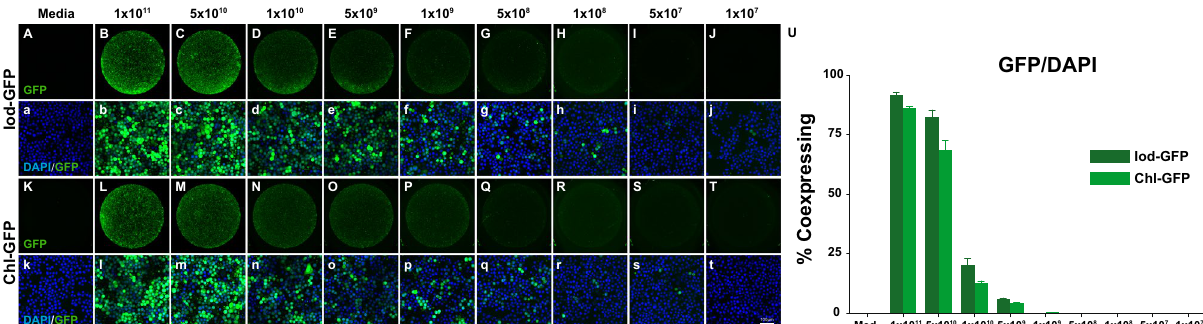
Figure 3. In vitro infectivity assay. Results from the in vitro transduction of HeLa cells for decreasing gc AAV- GFP vector produced from the Iod-GFP ( A – j ) and Chl-GFP ( K – t ) production methods. Representative low magnification images from the respective groups (Iod-GFP: A – j , Chl-GFP: K – t ) clearly display the decrease in fluorescence intensity. High magnification confocal microscopy images from the centre of the wells ( a – j and k – t ) indicate that there are a few cells expressing GFP even at relatively low gc-titers. ( U ) Quantifications for actual cell numbers co-expressing DAPI and GFP. Each condition was repeated in triplicates. Note that a conservative threshold was chosen hence underestimating the true transduction